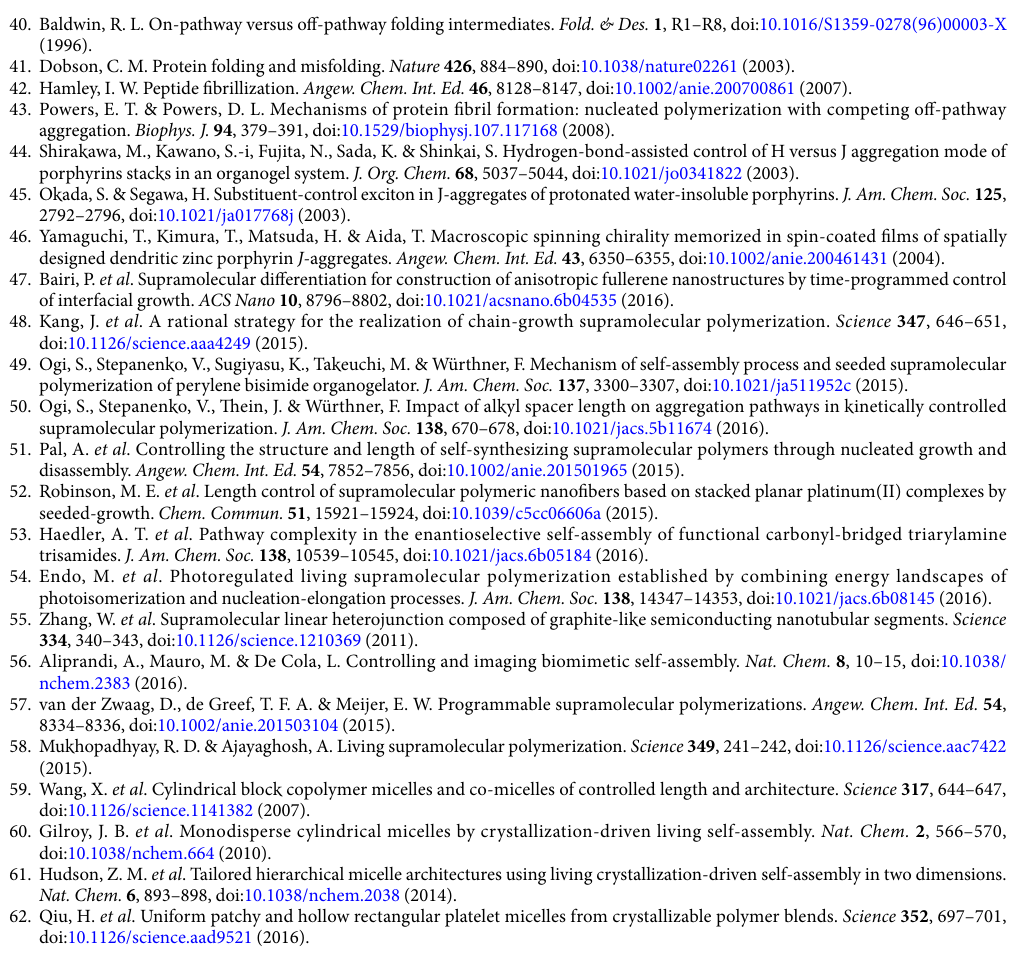
figuration: control of electron and structural dynamism for innovative functions” (No. 26102009) and “Dynamical ordering of biomolecular systems for creation of integrated functions” (No. 16H00787), and by